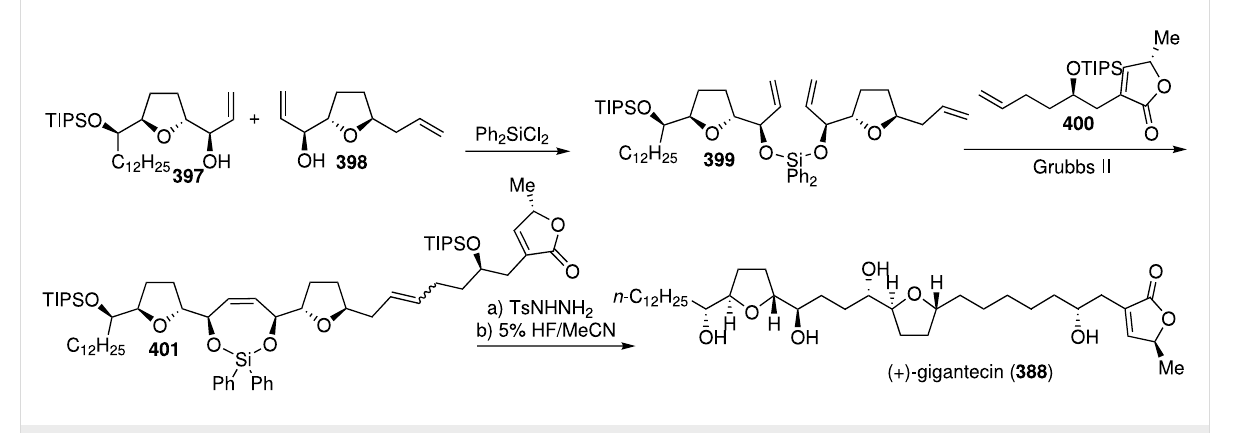
Scheme 56: Total synthesis of gigantecin by Crimmins’s group.